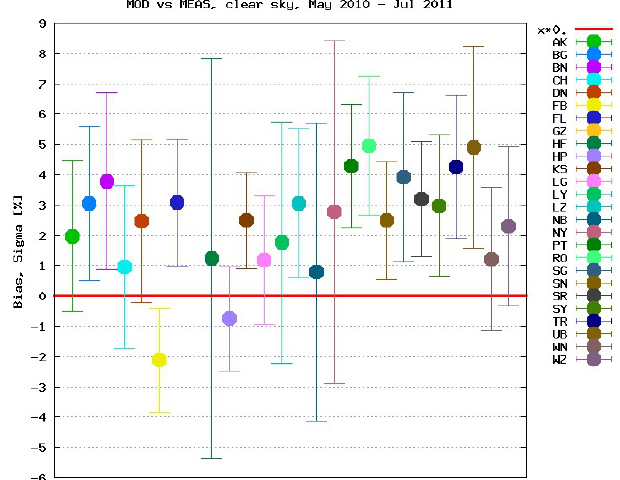
Figure 6. Systematic discrepancy and standard deviation of model calculations of downward total shortwave radiation from measured quantities, given for all pyranometer sites, expressed in percent.